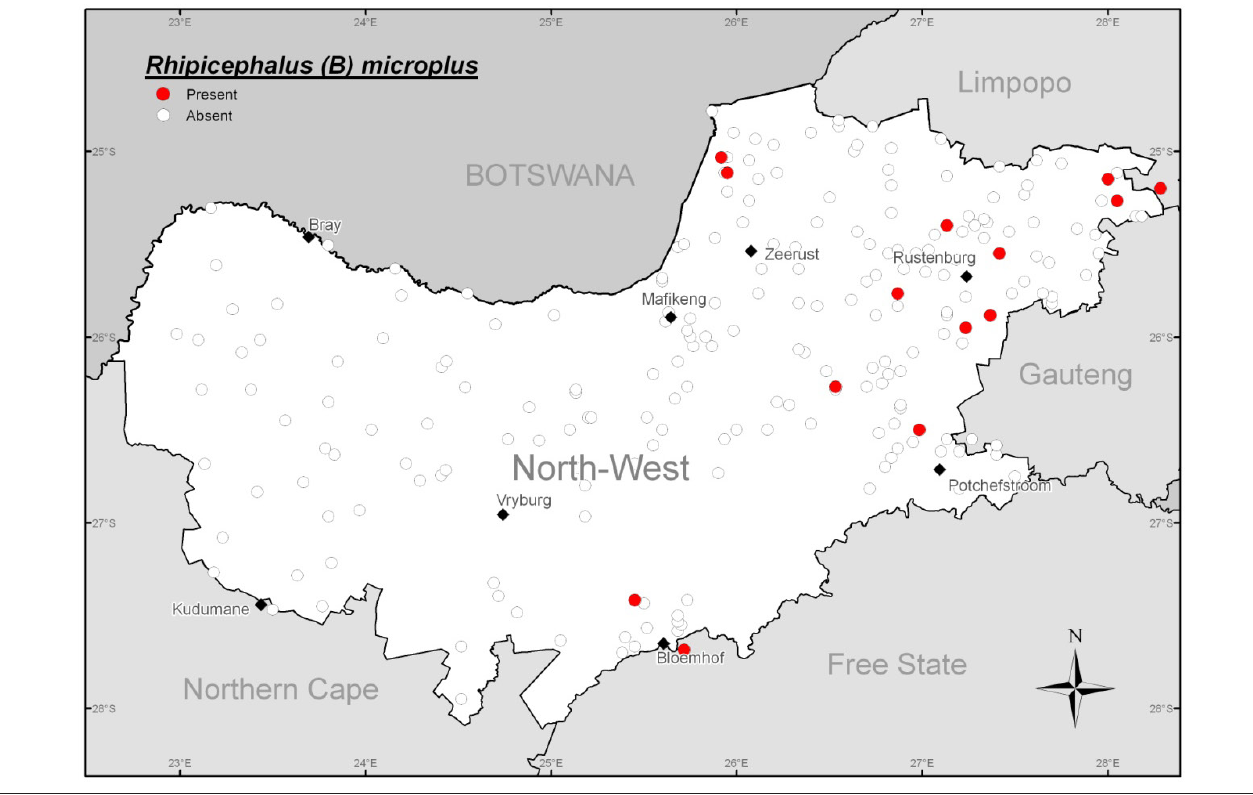
FIGURE 8: The geographic distribution of Rhipicephalus ( Boophilus ) microplus in the North West Province, South